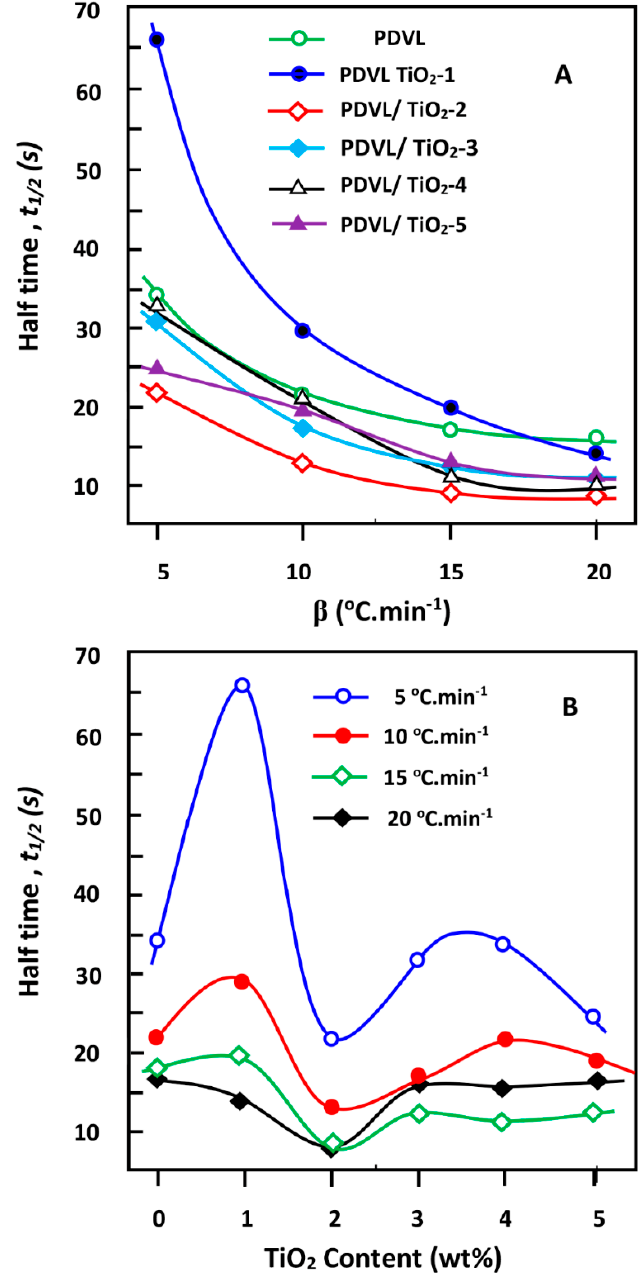
Figure 10. Variation of the t 1/2 value of the crystallization of pure PDVL and PDVL/TiO 2 nanocomposites versus ( A ) the cooling rate and ( B ) TiO 2 content.